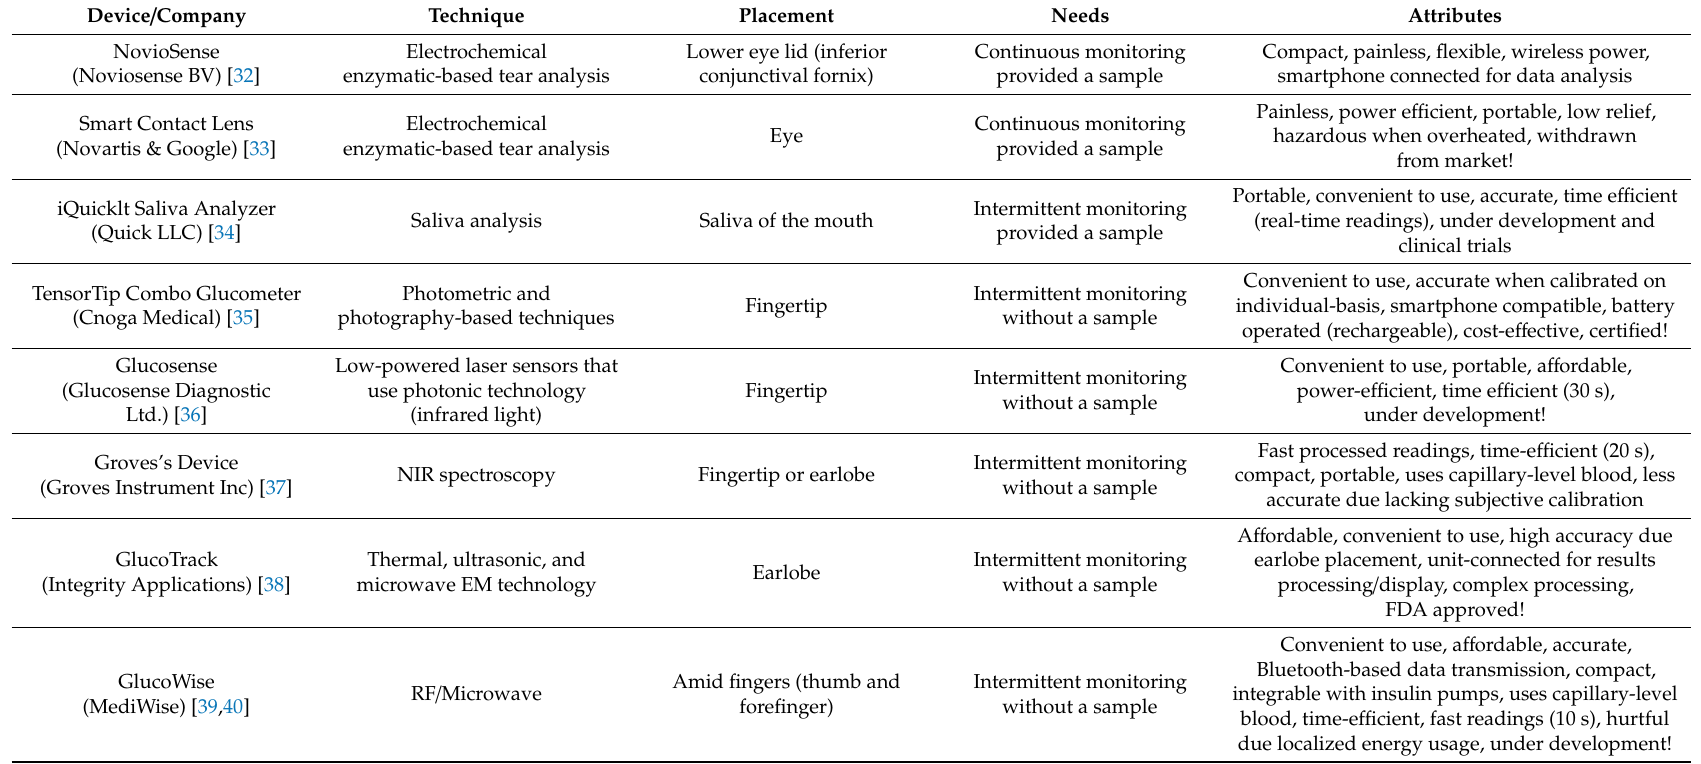
Table 1. In market devices for non-invasive blood glucose